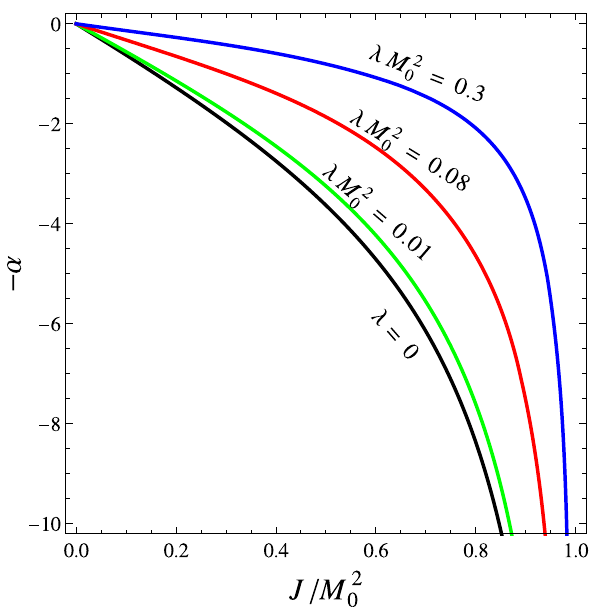
Fig. 8 Curves of the conjugate variable − α( J ) at fixed M . The λ = 0 (black) curve represents the stability curve of a Kerr black hole in the = standard approach within the microcanonical treatment. The λ M 2 0 = 0 . 08 (red) and λ M 2 = 0 . 3 (blue) curves are the 0 . 01 (green), λ M 2 0 0 stability curves of the Rényi approach. No vertical tangents occurs